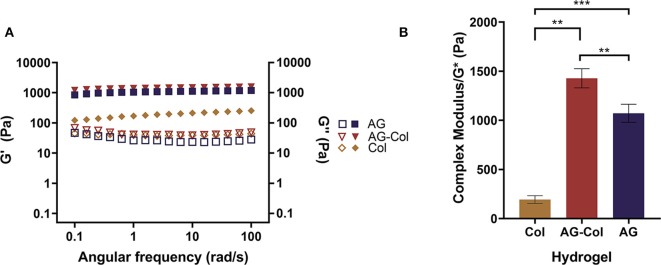
Rheological behavior of 0.2% collagen (Col), 1% agarose (AG) and 0.03% collagen+1% agarose co-gel (AG-Col) determined through parallel-plate rheometry. (A) Storage (shaded symbols) and loss (open symbols) moduli represent the elastic and viscous properties of the material. For all hydrogels the storage modulus exceeds the loss, indicating that the hydrogel is present in its gel state. (B) The complex modulus is used to represent the stiffness of the hydrogels. A statistically significant difference is observed between all groups, yet the stiffness for all remains within appropriate range for neuronal culture. Each data point represents the mean (n = 3) ± SD. (**p < 0.01 and ***p < 0.001).